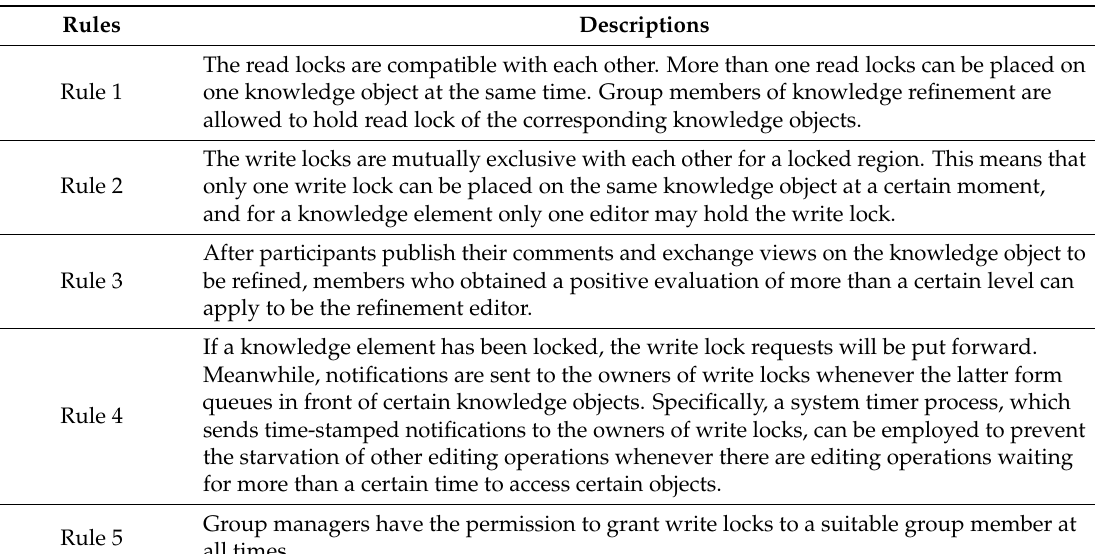
Table 1. Rules for lock-based knowledge collaborative editing and refinement (adapted from